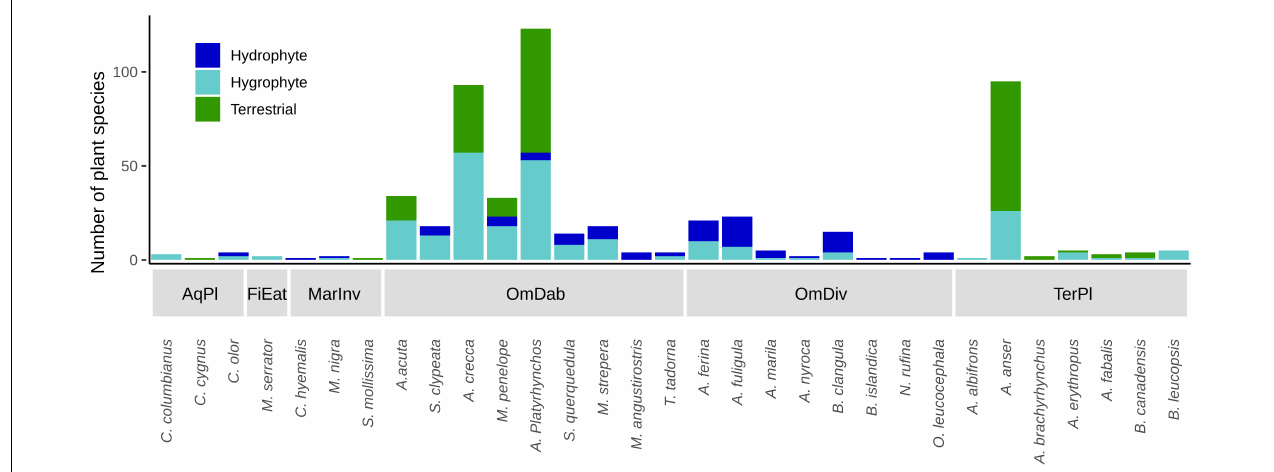
FIGURE 5 | Number of hydrophyte, hygrophyte and terrestrial plant species whose seeds are known to be ingested by each bird species in each feeding group. AqPl, Aquatic plant-eaters; FiEat, Fish-eating diving ducks; MarInv, Marine invertebrate-eating diving ducks; OmDab, Omnivorous dabbling ducks; OmDiv, Omnivorous diving ducks; TerPl, Terrestrial plant-eaters. See Table 1 for full names of bird